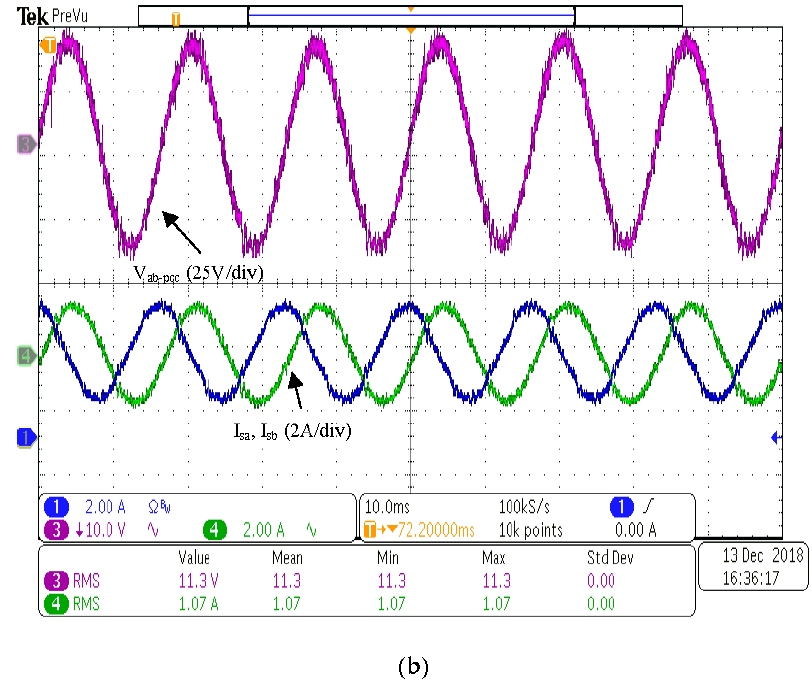
Figure 12. ( a ) v ab-pcc , i sa and i sb without the filter. ( b ) v ab-pcc , i sa and i sb with the filter. (10 ms/div). (B) BLL